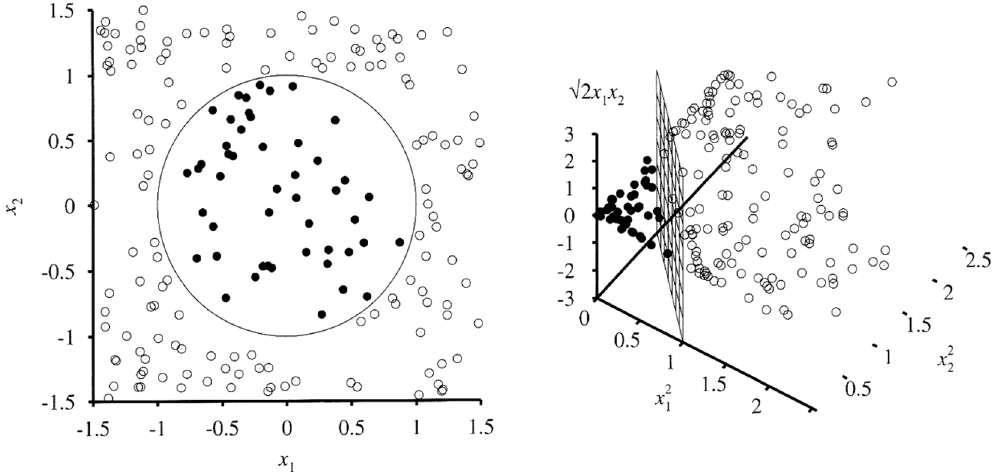
Figure 14. Feature space